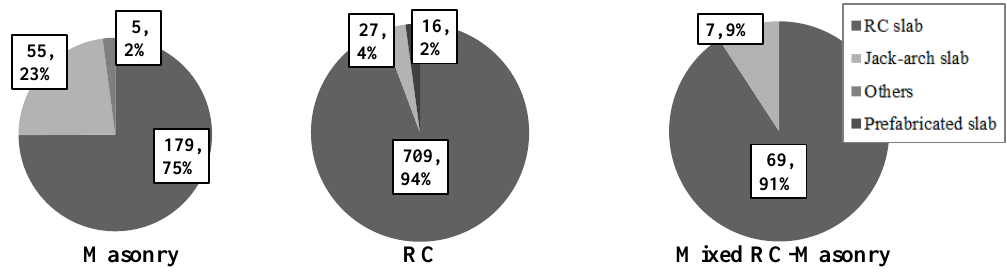
Figure 4. Occurrence of different horizontal structural systems within the dataset of 1067 buildings.